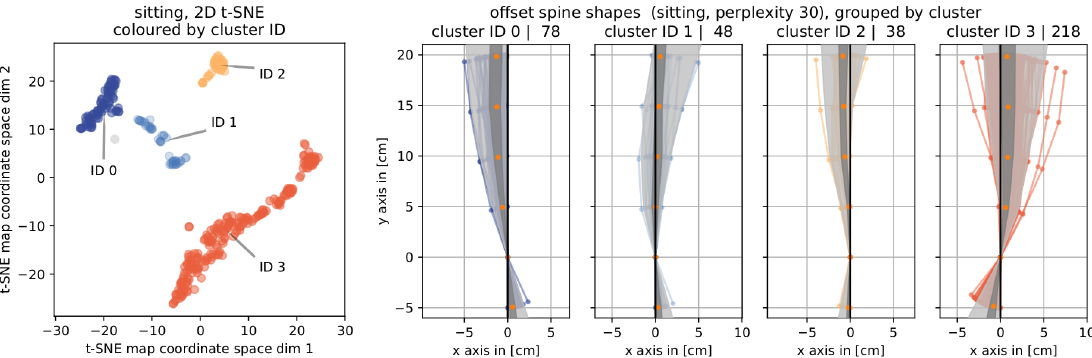
Figure 8. Results for clustering posture pairs of sitting . ( left ) The t-SNE map labelled with and colored by cluster ID. ( right ) Corresponding cluster bundles of offset spine shapes including information about the cluster ID and the number of elements in that